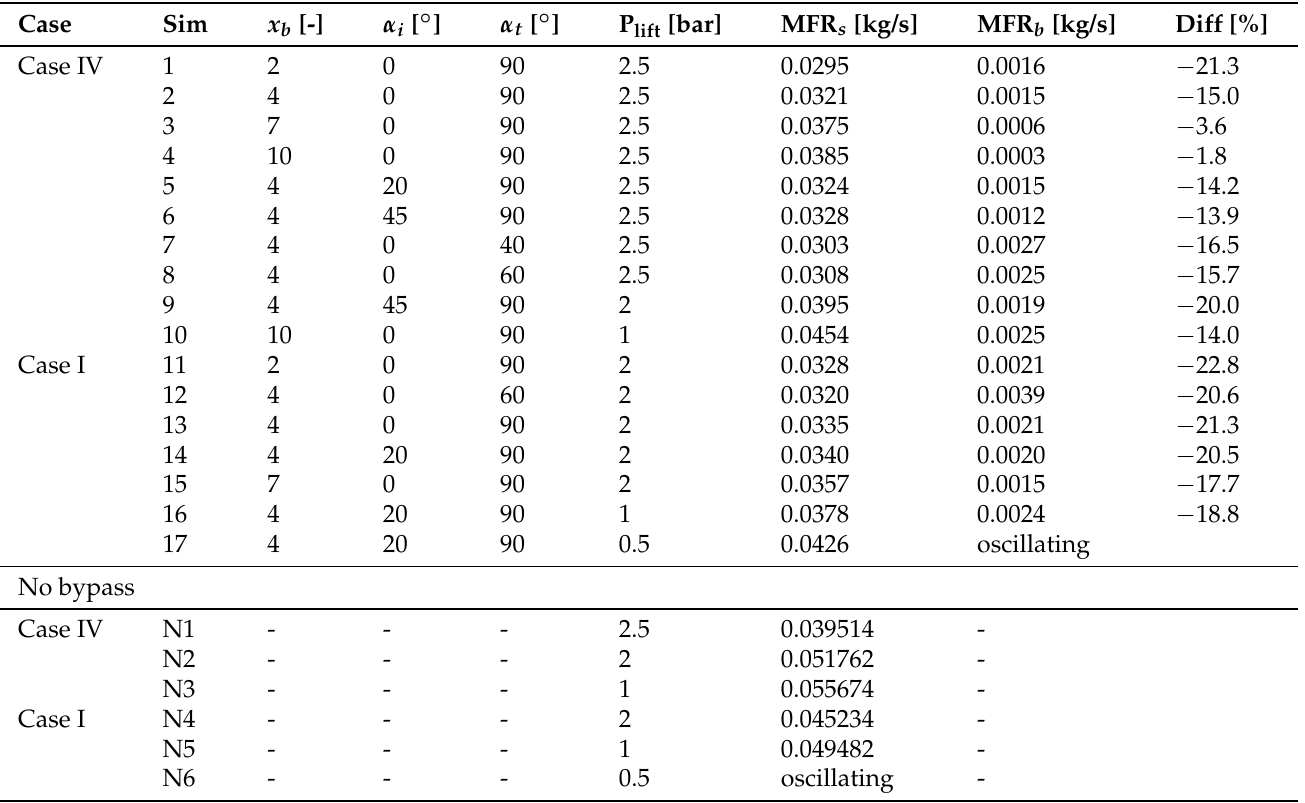
Table 6. Parameter study of the different geometric features of the bypass inlet on bypass perfor- mance. Simulations are identified by the simulation ID Sim, where the prefix N indicates no-bypass. The column named Diff is defined as the difference in percentage between the total entrainment (bypass and suction) compared to the same operating condition without